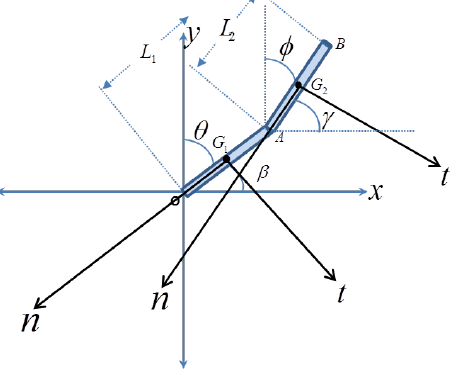
Figure 1. Two DOF model with points A, G2 and B representing the hip, chest and head positions,